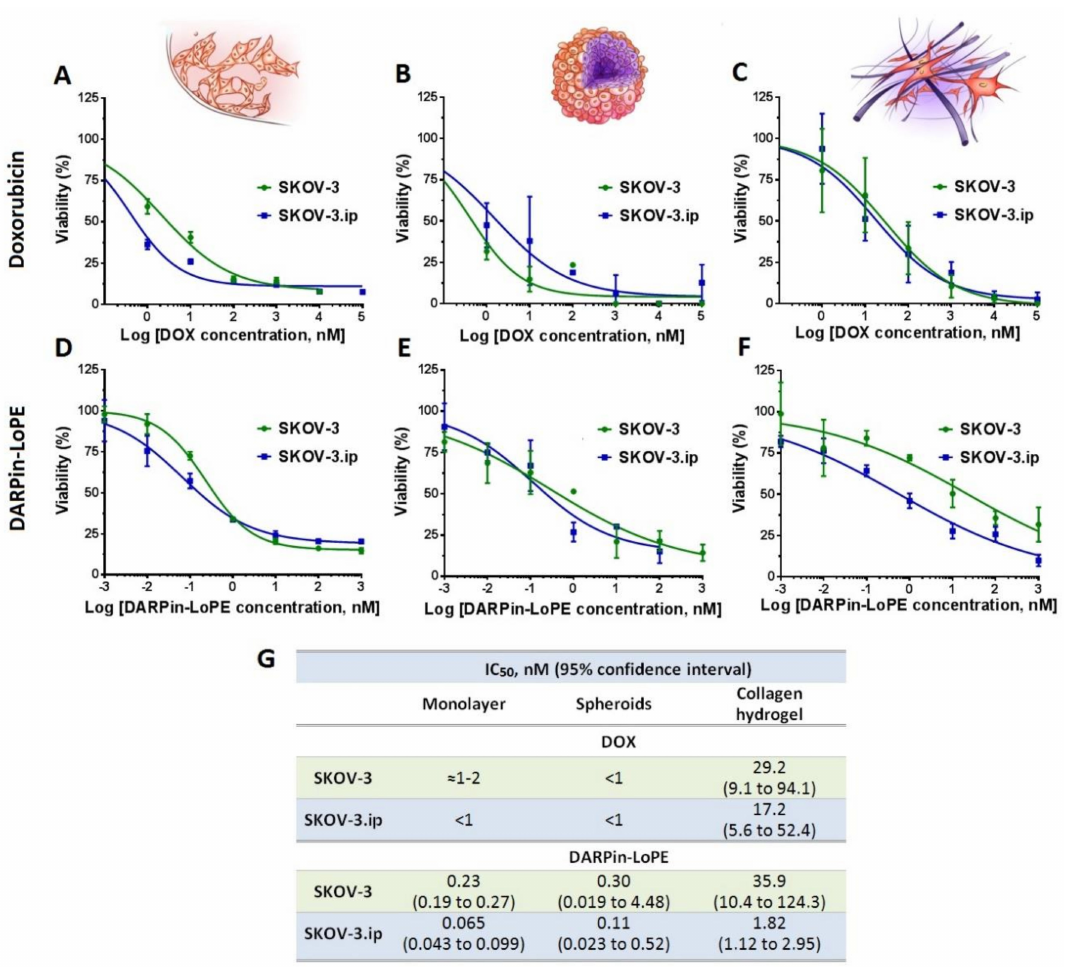
Figure 6. Cytotoxicity of doxorubicin and targeted toxin DARPin-LoPE against SKOV-3 and SKOV-3.ip cells cultured in monolayer and 3D in vitro models. Upper row: doxorubicin cytotoxicity against ( A ) monolayer culture, ( B ) spheroids and ( C ) collagen hydrogel. Lower row: DRAPin-LoPE cytotoxicity towards ( D ) monolayer culture, ( E ) spheroids and ( F ) collagen hydrogels. Data are presented as mean ± SEM ( n = 6). ( G ) Half maximal inhibitory concentration IC 50 values, calculated for treated